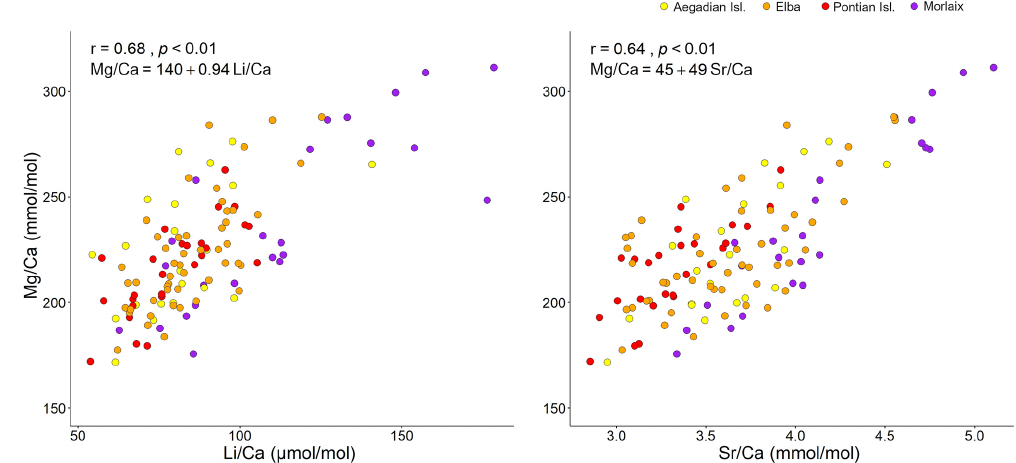
Figure 3. Correlation plots of Mg / Ca with Li / Ca and Sr / Ca. For each analysis the Spearman’s coefficient r , the p value, and the line equation are given.